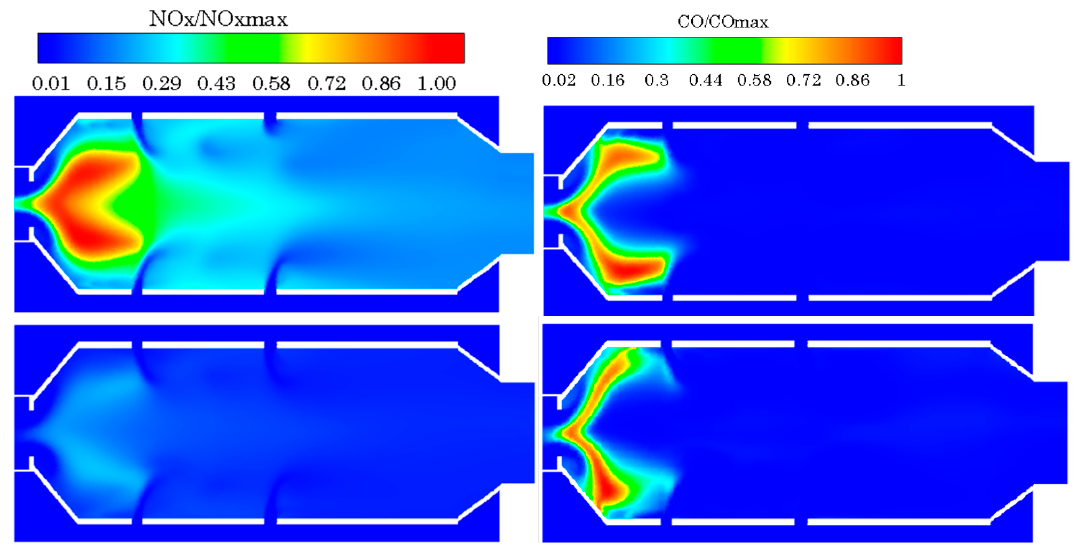
Figure 20. NOx and CO characteristics for natural gas ( top ) and biogas ( bottom ).